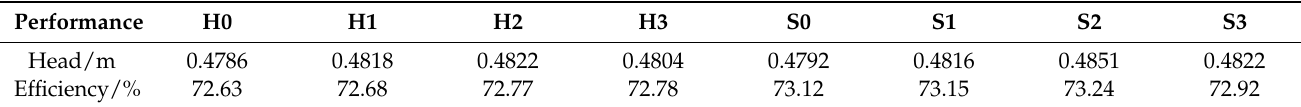
Figure 6. Variation in the trend of hydraulic performance under two types of schemes: ( a ) S scheme; ( b ) H scheme. Table 2. Hydraulic performance of different schemes under design